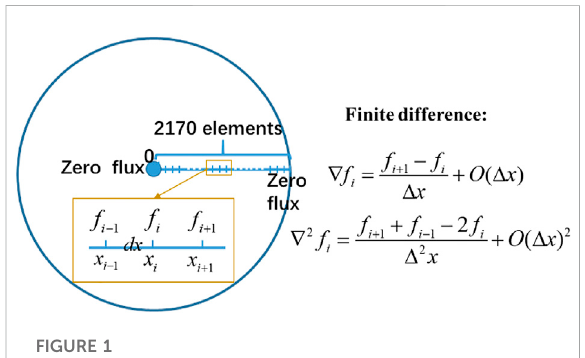
FIGURE 1 Schematic diagram of fi nite difference method